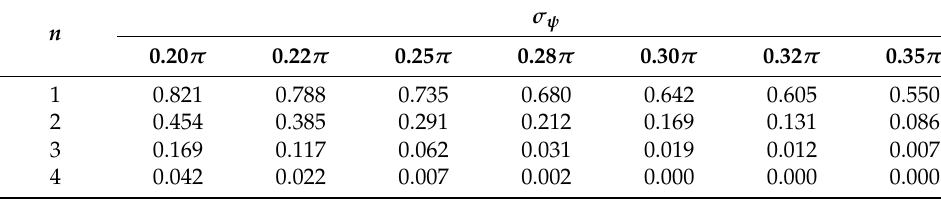
Figure 1. Crowd reduction factors C ψ ( n ) . Table 1. Crowd reduction factors C ψ ( n )